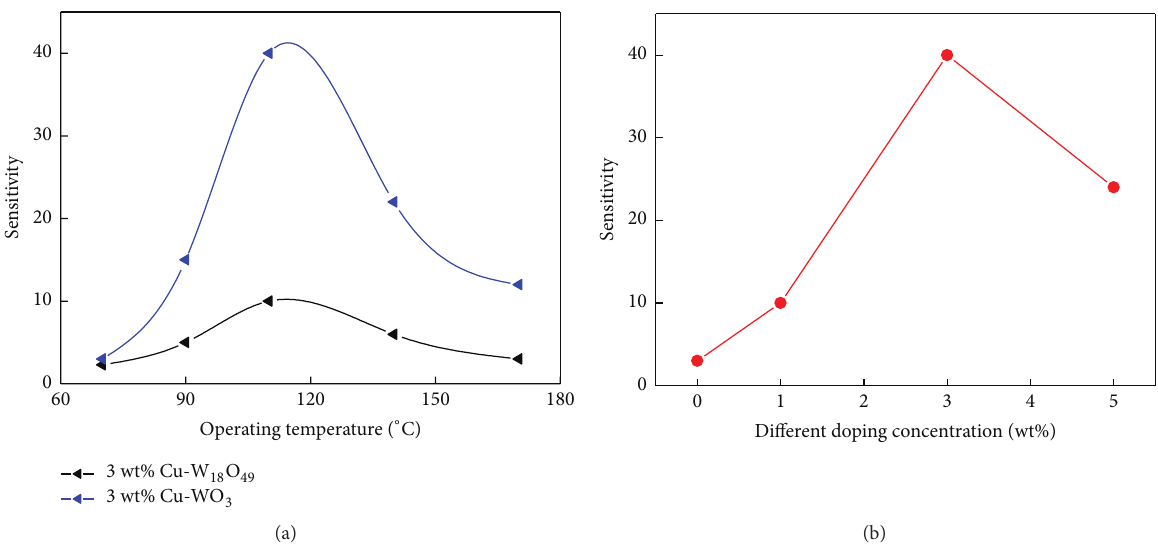
Figure 3: (a) Sensitivity of the Cu-doped W 18 O 49 (black line) and WO 3 (blue line) sensor towards 10ppm acetone under different operating conditions. (b) Different doping concentrations of copper in flower-like WO 3